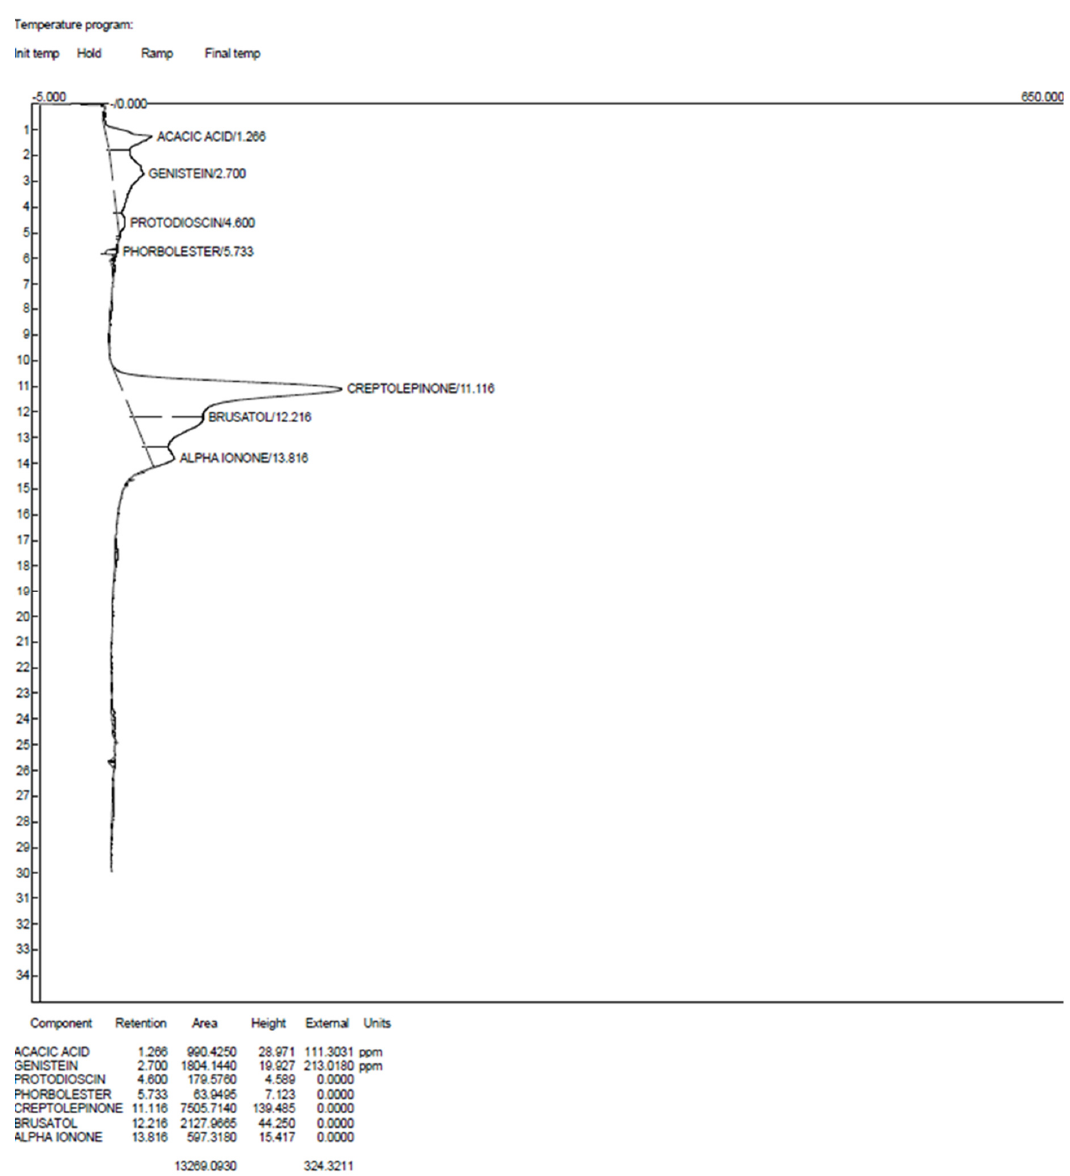
Figure 10. Chromatogram of ethyl acetate extract of C. papaya